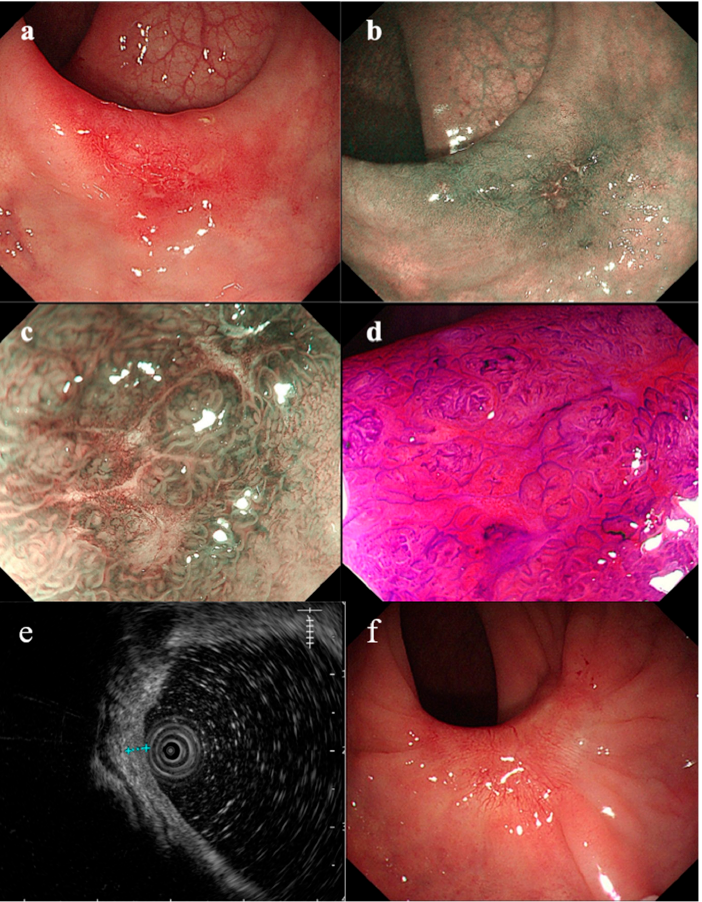
Figure 1. Endoscopic view of rectal lesion: ( a ) white-light endoscopy; ( b ) narrow-band imaging; ( c ) magnified version of the image in ( b ); ( d ) magnified endoscopic view after crystal violet staining; ( e ) the ultrasound image; ( f ) the white-light image of the scar.